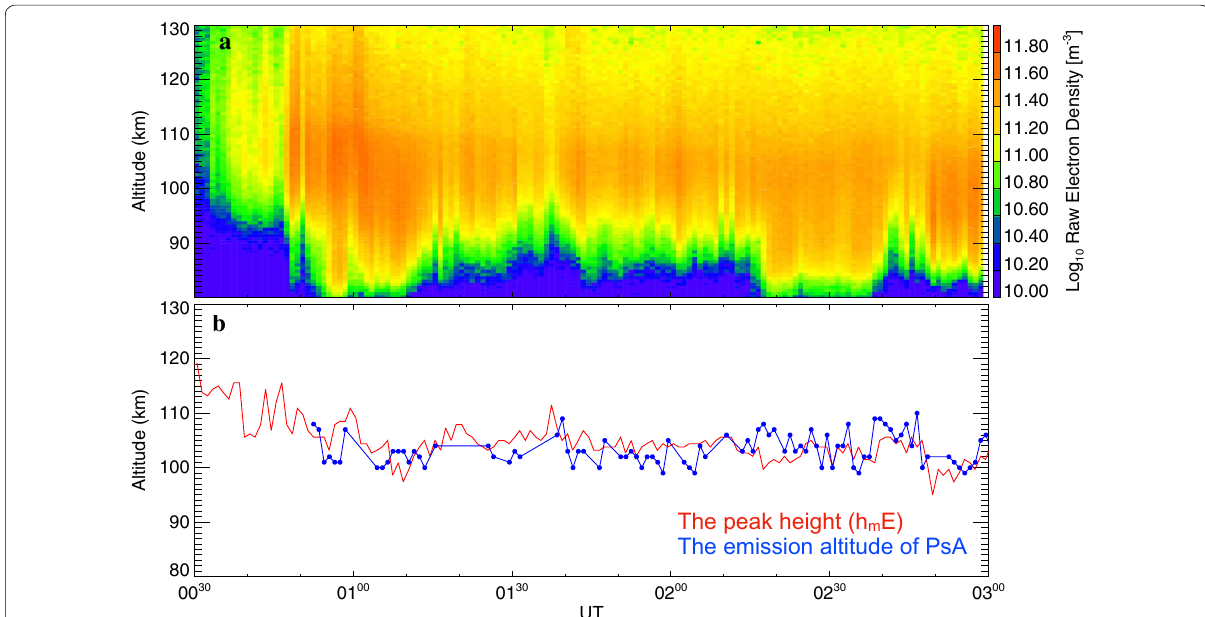
Fig. 4 a Altitude‑time plot of the ionospheric raw electron density (i.e., power profile data) obtained by the EISCAT UHF radar for an interval of pulsating aurora from 00:30 UT to 03:00 UT on 19 February 2018. b Time‑series of the emission altitude of pulsating aurora estimated from the lifetime of O( 1 S) (blue line) and the peak height of E region ionization ( h m E ) from EISCAT (red